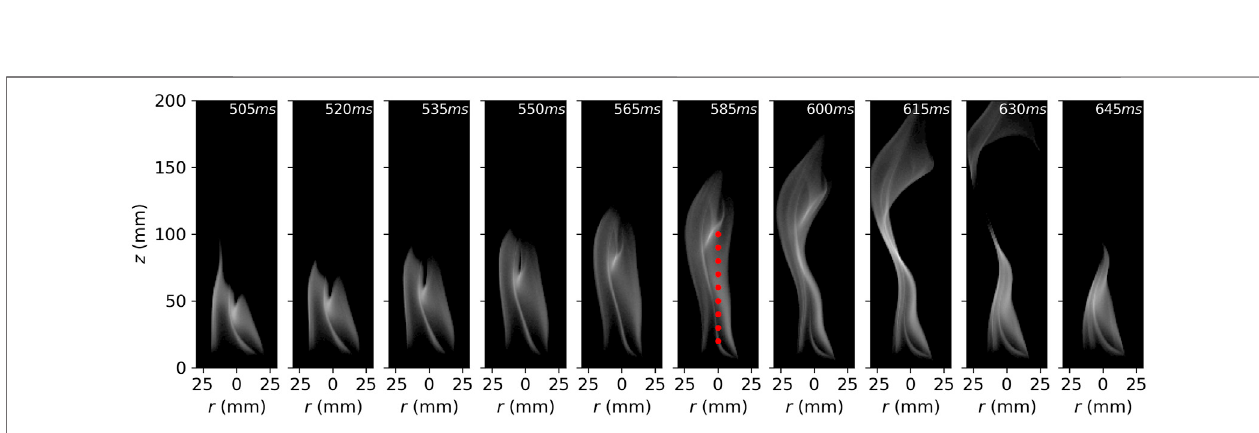
FIGURE 2 | On left: Spectral radiance of the broadband light source used for calibration of AC-LII detection system. On right: Photomultiplier tubes (PMT) signal reference ( S ref ) for different voltage controls (PMT gain), measured during the calibration procedure.